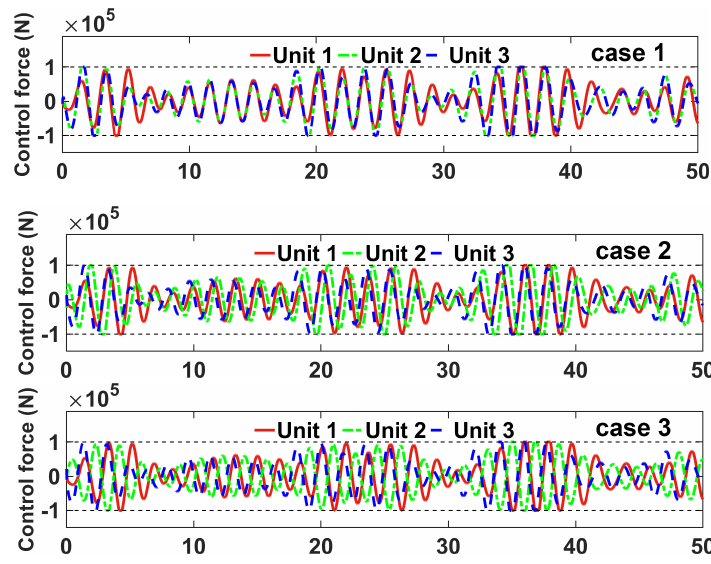
Figure 5. Reaction force controlled by the MPC